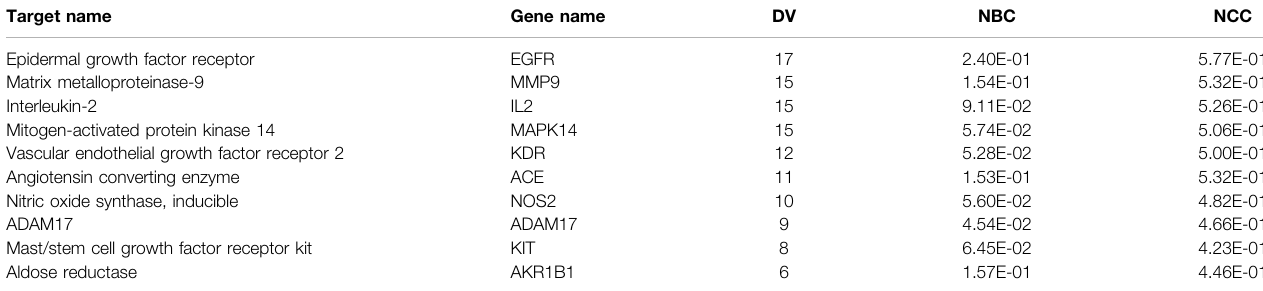
TABLE 2 | The topological parameters of the 10 key